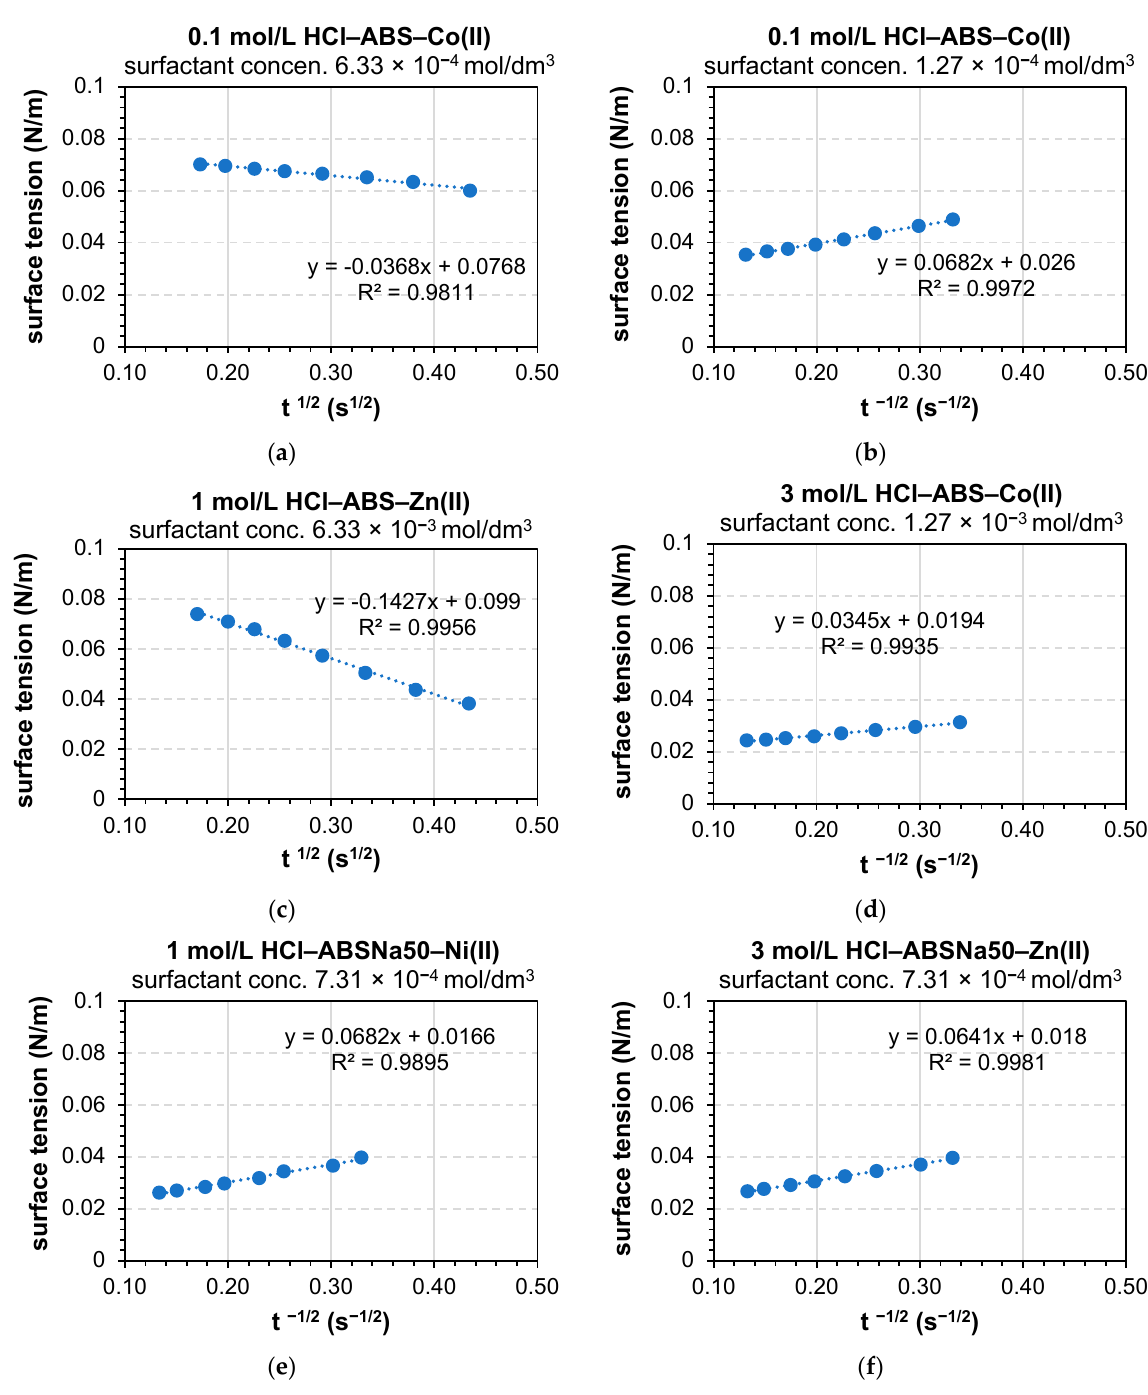
Figure 9. Selected examples of approximation plots (short, long time) in the HCl–AS–M(II) systems where AS indicates ABS ( a – d ) and ABSNa50 ( e , f ) surfactants.